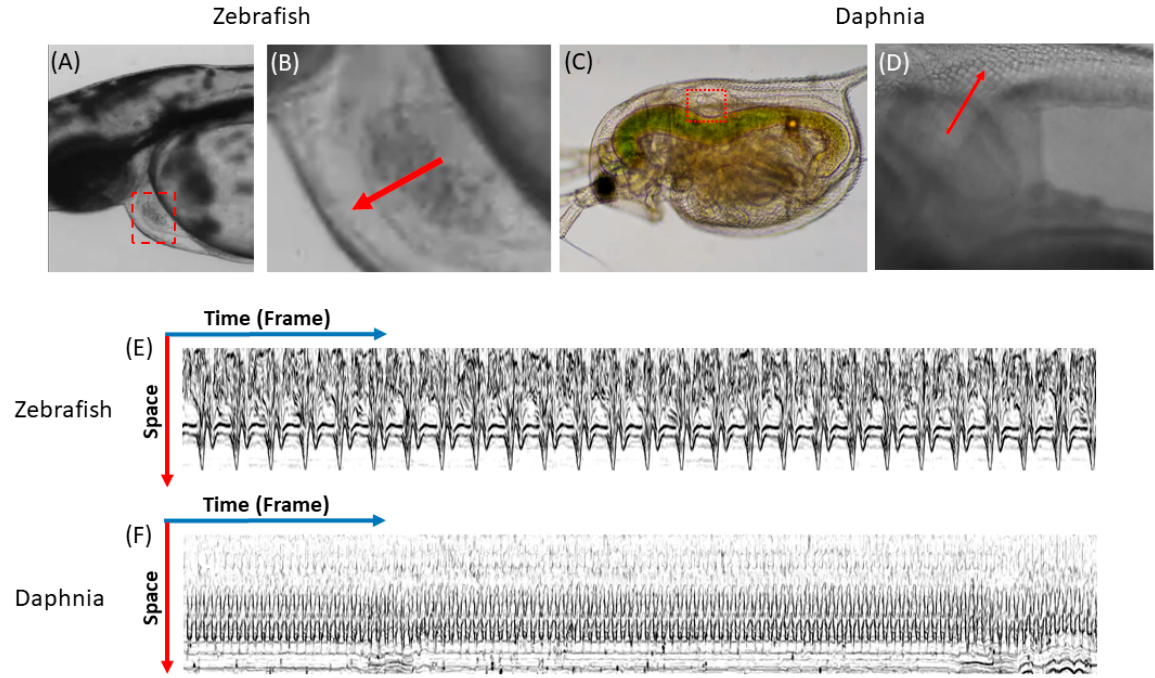
Figure 1. Principle for heartbeat measurement in zebrafish embryo and Daphnia magna neonates using kymograph. ( A ) The position used to calculate heartbeat in zebrafish embryo aged at 72 h post-fertilization, ( B ) direction of the line made before dynamic resliced in zebrafish, ( C ) the outlook of Daphnia magna showing the relative positions of heart, ( D ) direction of the line made before dynamic resliced in D. magna (area inside the red dashed line ( A , B ) show the location of heart chamber in zebrafish and Daphnia , while red arrow ( B , D ) represents the location and direction of ROI selection), ( E ) the kymograph pattern of zebrafish heartbeat, and ( F ) the kymograph pattern of D. magna heartbeat.